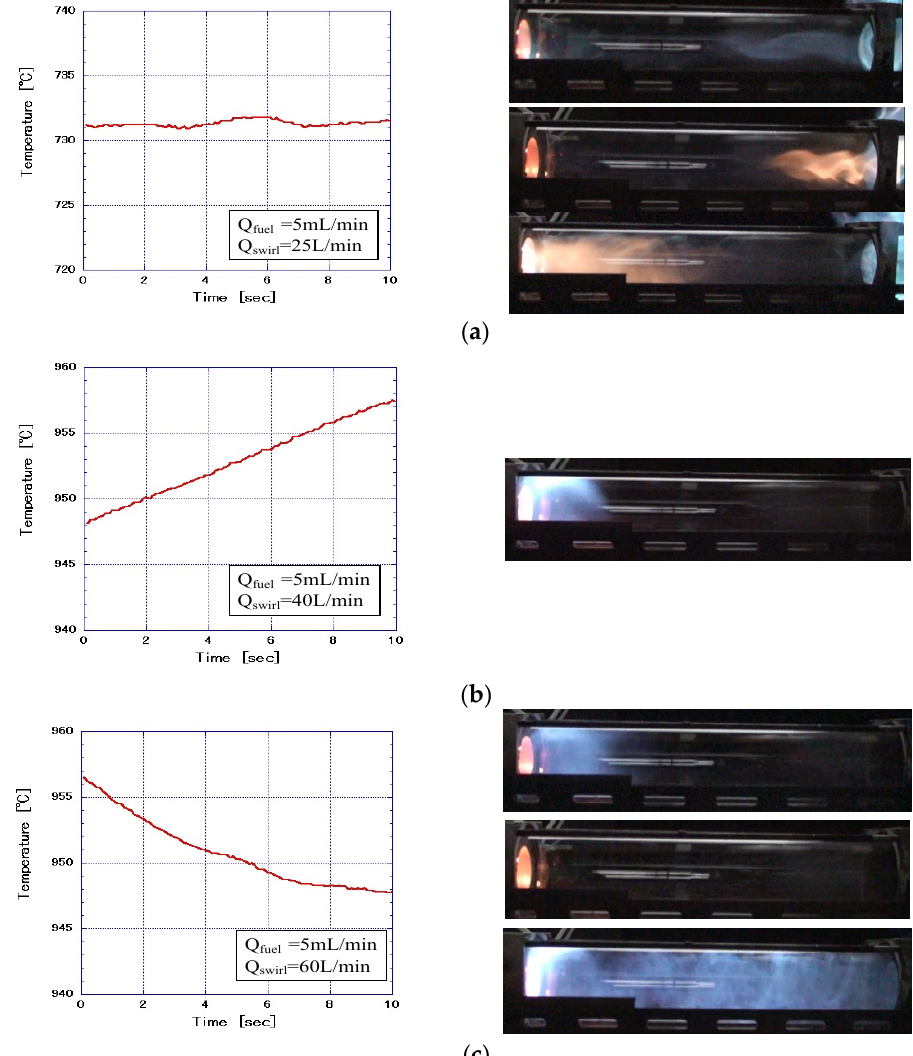
Figure 12. Temperature fluctuation in the combustion chamber (Q fuel = 5 mL/min fixed). ( a ) Q swirl = 25 L/min. ( b ) Q swirl = 40 L/min. ( c ) Q swirl = 60 L/min.